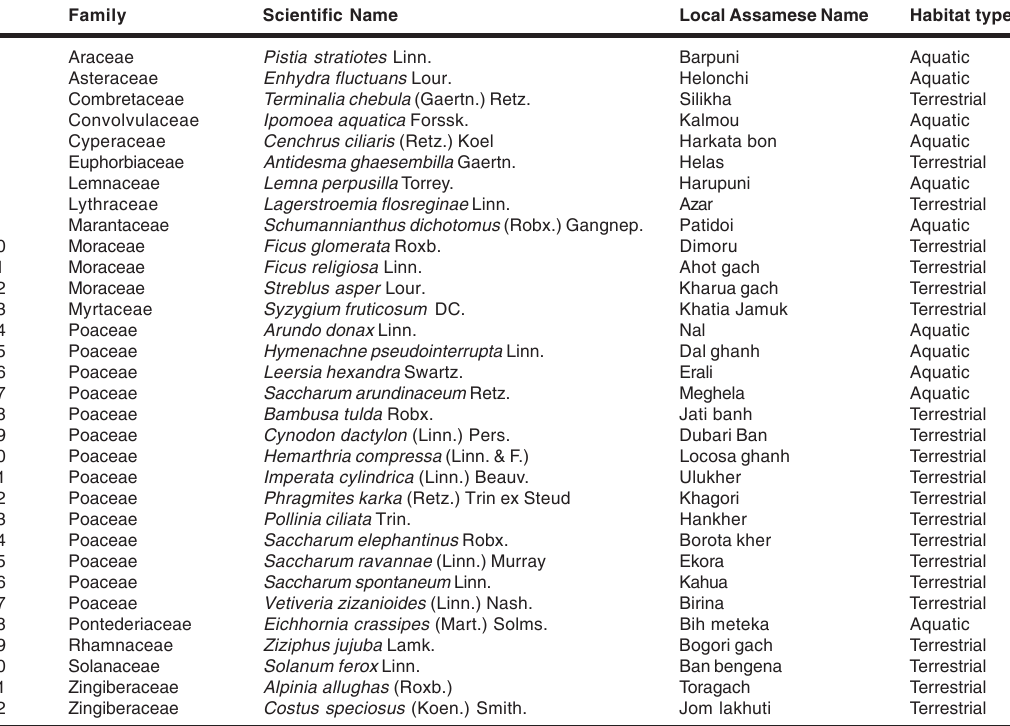
Table 1. List of natural food plant species of rhinos in Pobitora Wildlife Sanctuary